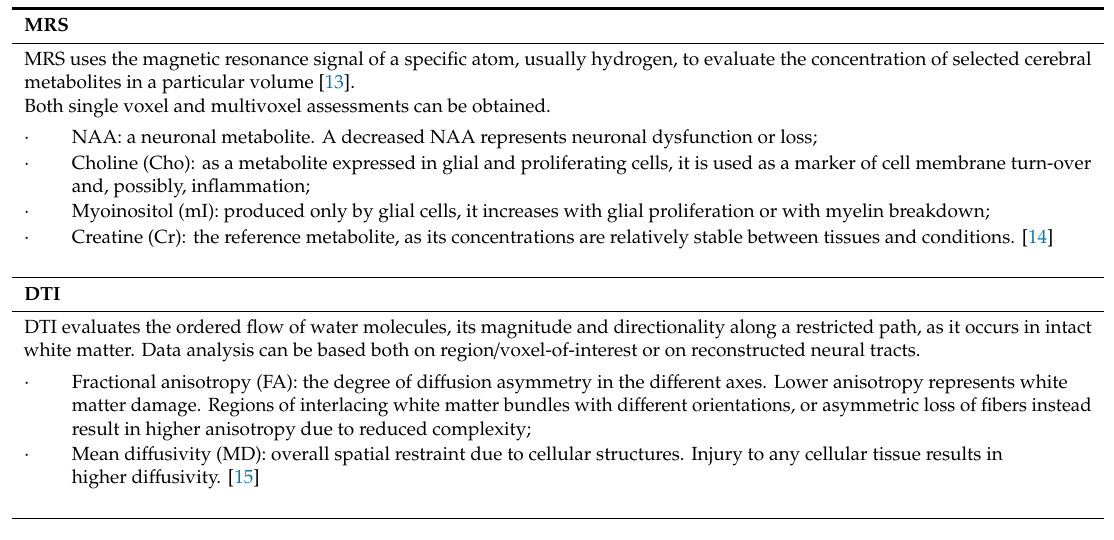
Table 1. Overview of advanced imaging